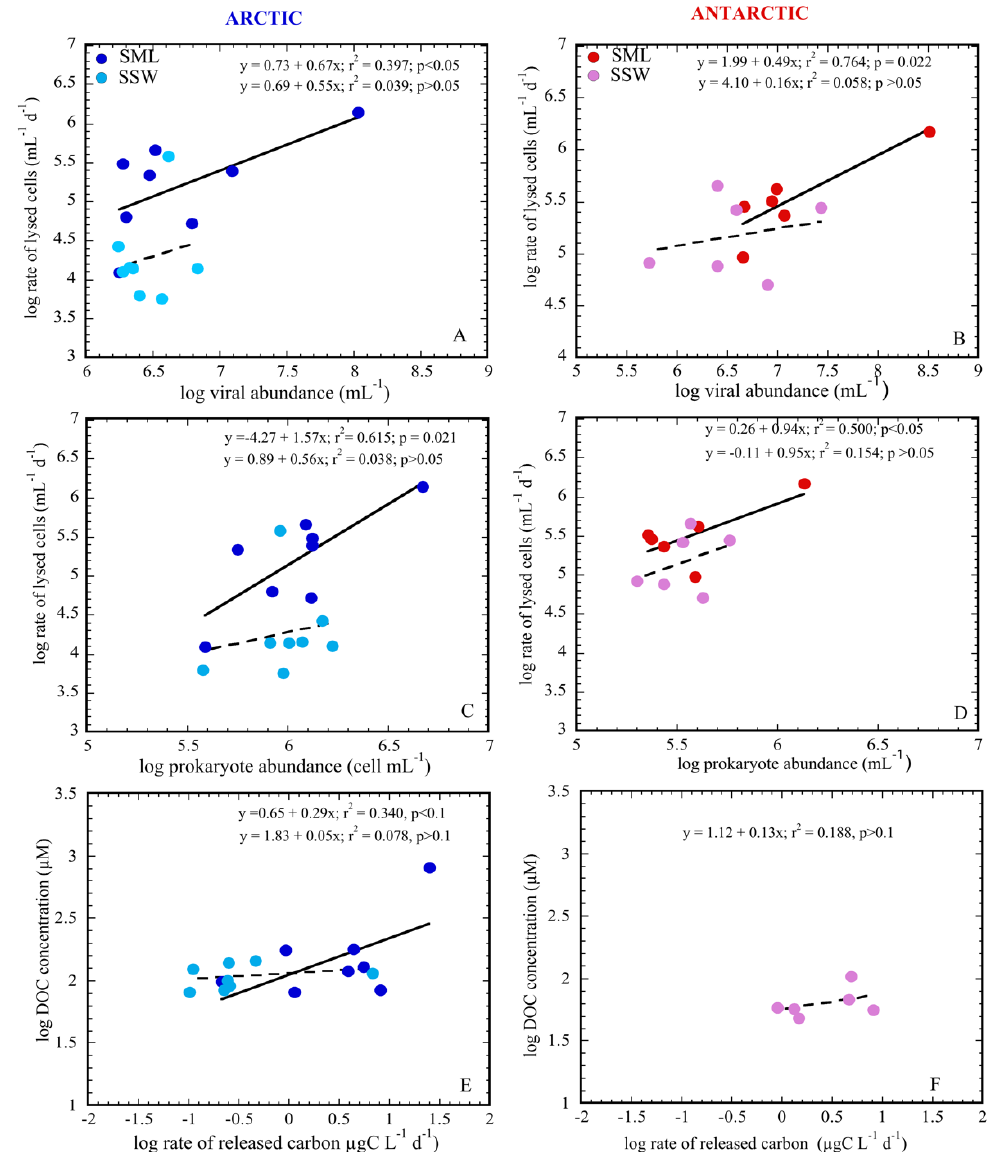
Figure 4. Regression analyses between the rate of lysed cells (RLC) with viral and host abundances, and the rate of released carbon with DOC in Arctic ( A , C , E ) and Antarctic ( B , D , F ) waters for the SML and SSW. Significant levels of p < 0.05 and of 0.05< p < 0.1 were considered. Analyses and drawings were performed using the JMP 8.0 and Kaleidagraph 4.0 programs.